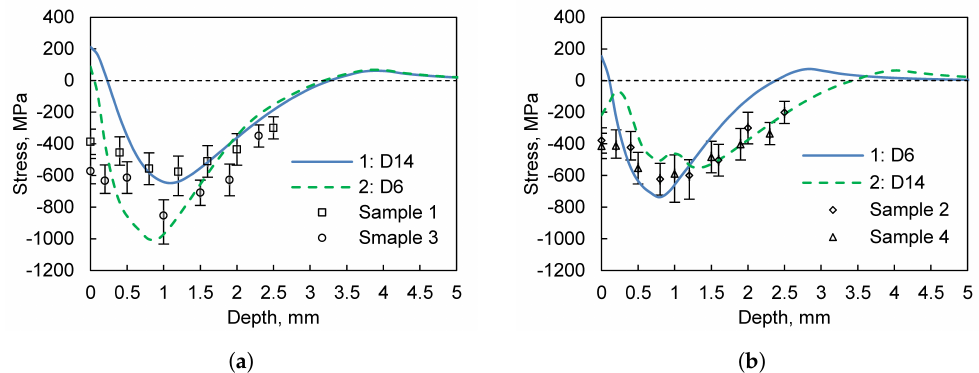
Figure 12. Stress field of combined hammering simulation and measured values on samples.